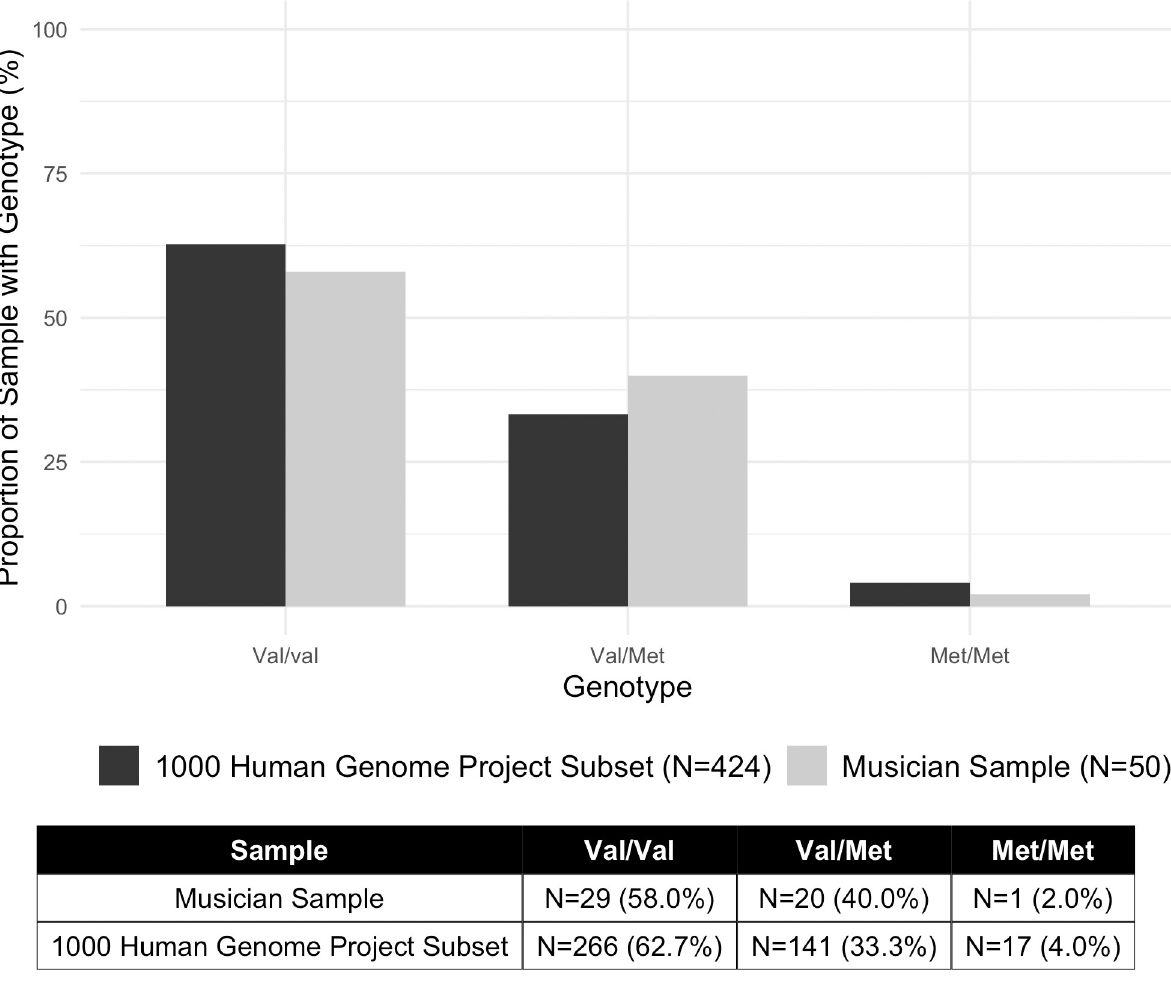
Fig 1. Genotype frequency distributions in the musician sample and 1000 human genome project subset.